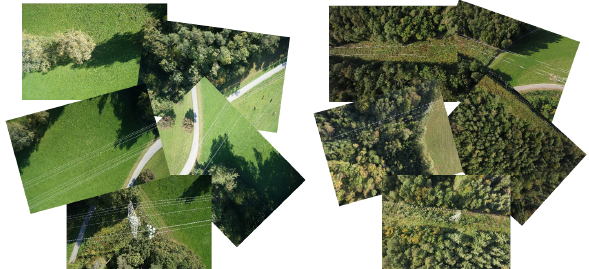
Figure 5. Comparison of acquired image sets. The differences in resolution (see power pylon) and the changes in season are visible.